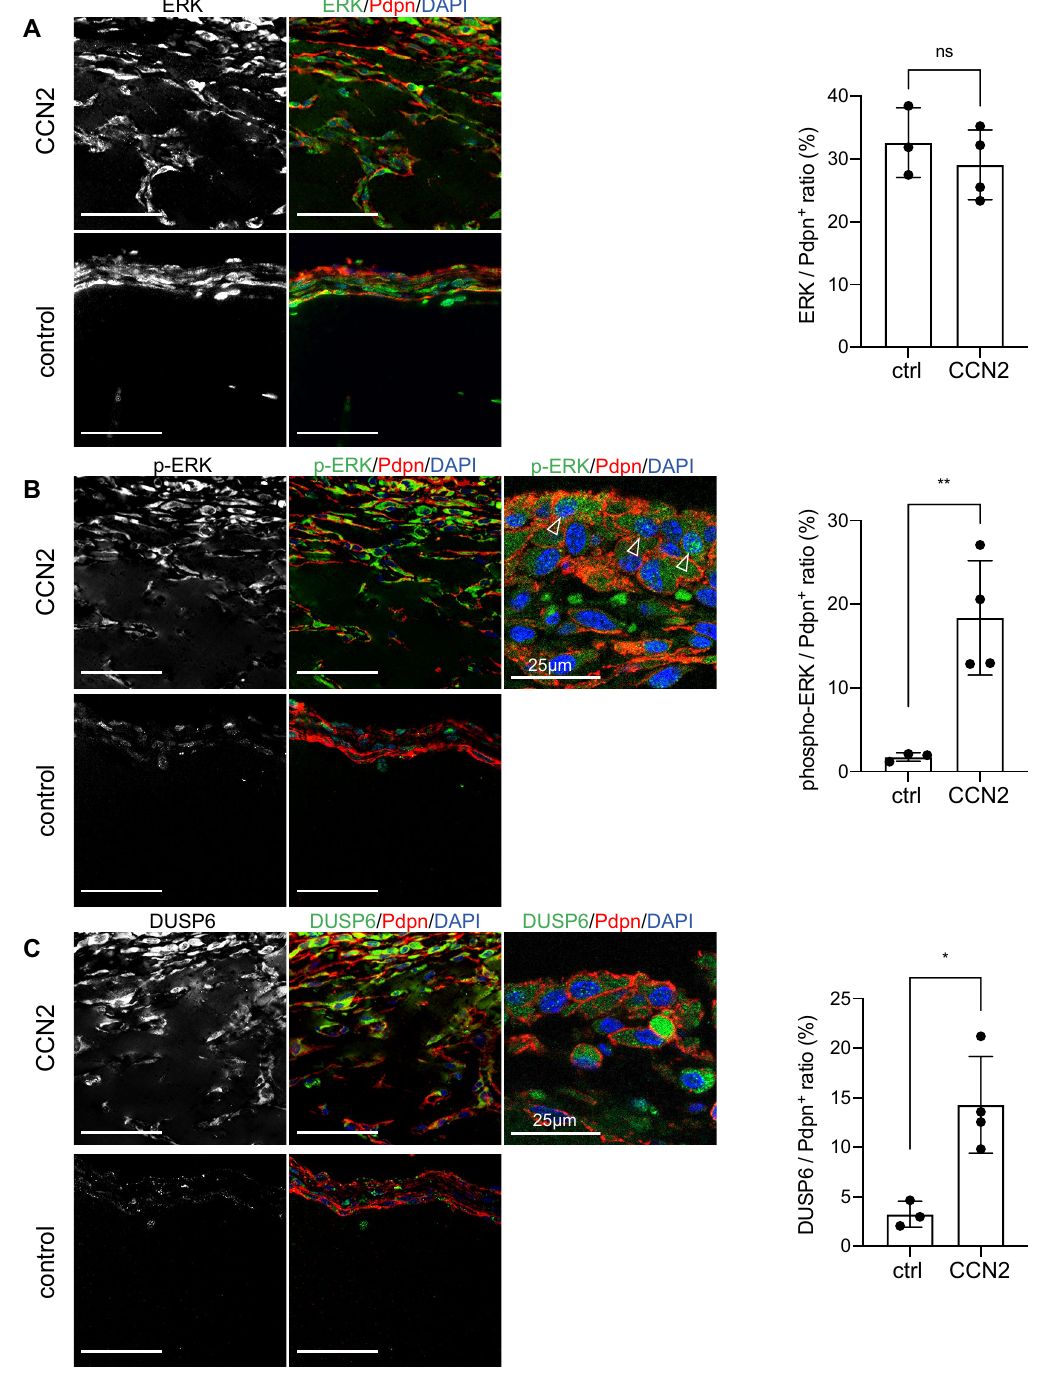
Figure 7. Enhanced expression of phospho-ERK and DUSP6 in the CCN2 Matrigel. Expression of phospho- ERK, DUSP6 and ERK in Matrigel plugs detected by immunostaining (left) and quantification of the ratio of the ERK, phospho-ERK or DUSP6-positive area to the Podoplanin-positive area for each gel (right). ERK ( A ), Phospho-ERK ( B ) and DUSP6 ( C )-positive cells were detected in both the CCN2 gel and control gel. Arrowheads indicate Podoplanin-positive/phospho-ERK-positive cells. Scale bars: 50 µm. Student t test, * p < 0.05, ** p < 0.01. ns; not